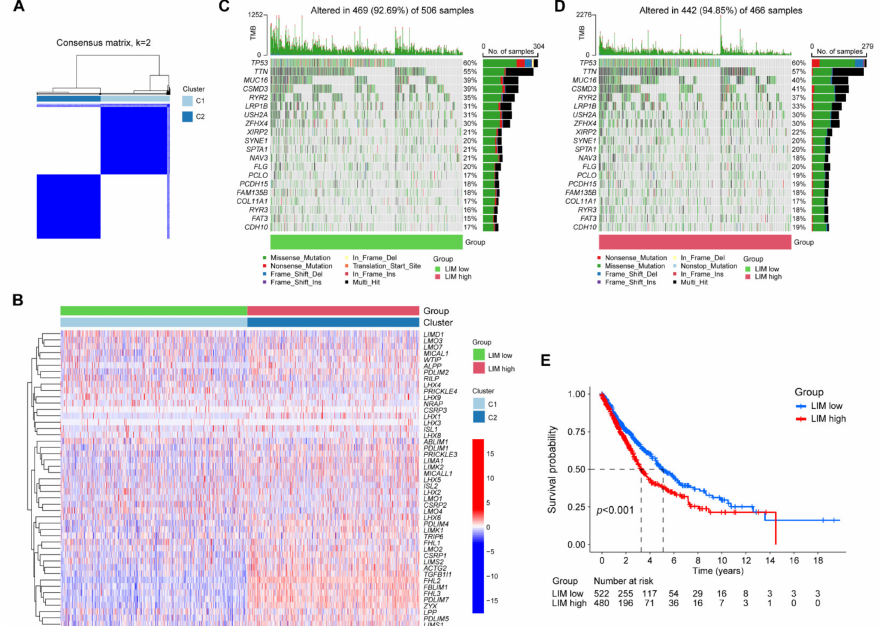
Figure 2. Identification of LIM domain family gene-related clusters in non-small-cell lung cancer (NSCLC). ( A ) According to the consensus cluster analysis, NSCLC samples were classified into two distinct gene clusters, with the optimal k = 2. ( B ) Unsupervised clustering of 47 LIM domain family genes in patients with NSCLC. The waterfall plots of tumor somatic mutation of the LIM-low group ( C ) and the LIM-high group ( D ). ( E ) Kaplan–Meier overall survival curves for the two groups in patients with